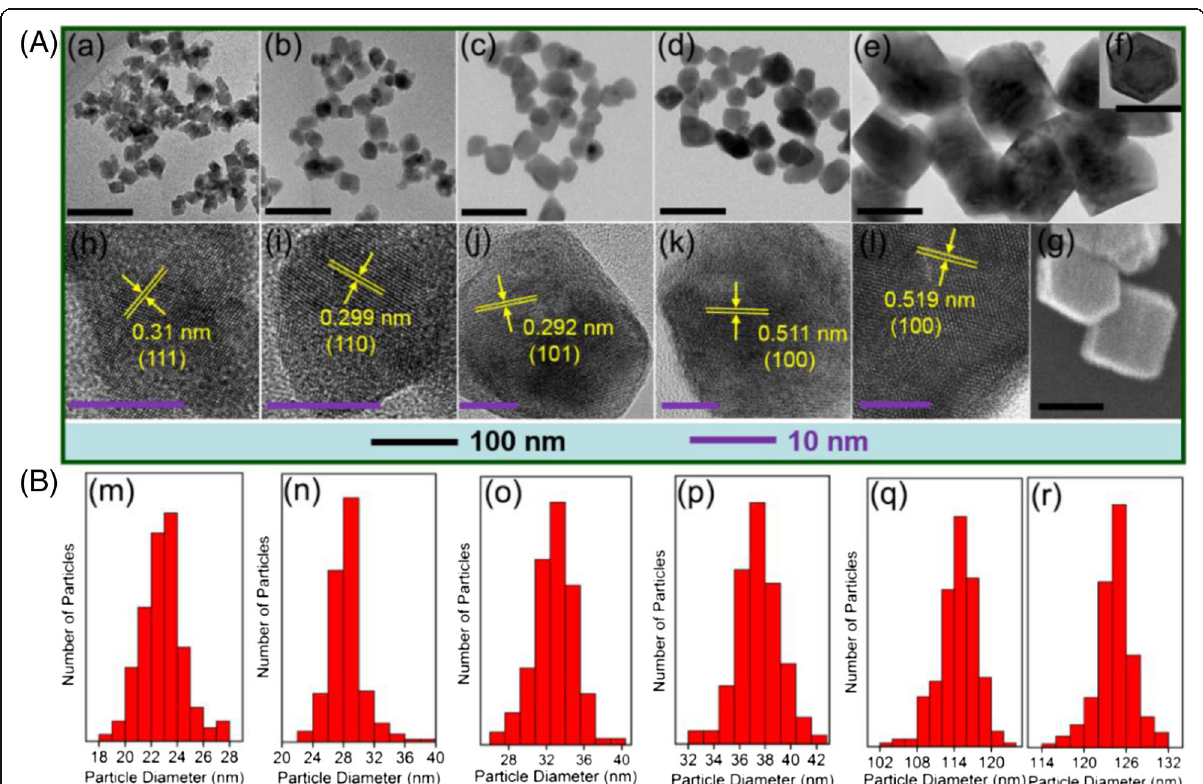
Fig. 4 A TEM and HRTEM images of the as-prepared cubic core crystals and heterogeneous core/shell crystals. TEM images of (a) cubic NaGdF 4 core nanocrystals, (b) – (e) heterogeneous NaGdF 4 / NaYF 4 core/shell crystals with the shell growth time of 2, 6, 12, and 24 h, respectively, (f) a single particle of the 24-h-reaction NaGdF 4 / NaYF 4 core/shell crystals which stand on the TEM grids on their bottom faces. (g) SEM image of the 24-h-reaction NaGdF 4 /NaYF 4 core/shell crystals, which exhibit a hexagonal nanoprism look. HRTEM images of (h) cubic NaGdF